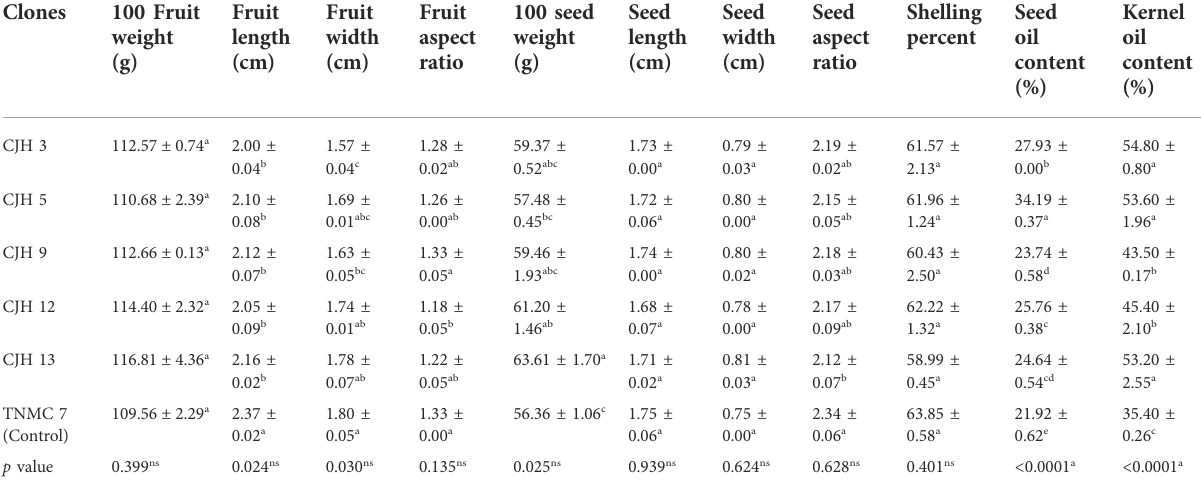
TABLE 2 Mean performance in fruit and seed attributes of Jatropha hybrid clones. Clones 100 Fruit